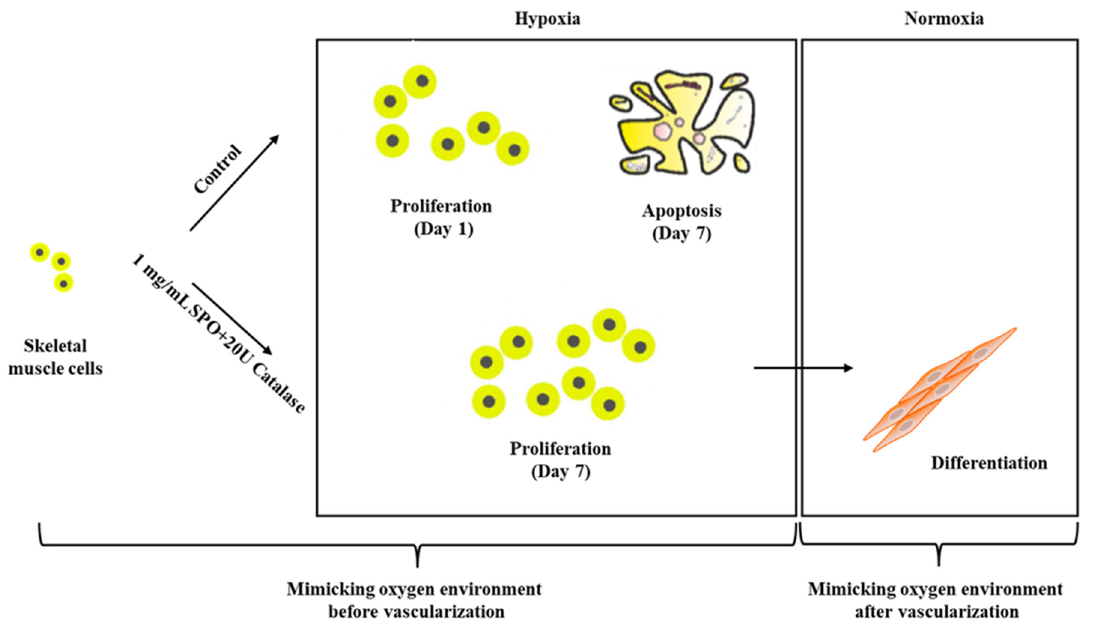
Figure 6. Schematic of cell preservation using 1 mg/mL SPO + 20 U catalase to mimic an oxygen environment before and after vascularization.